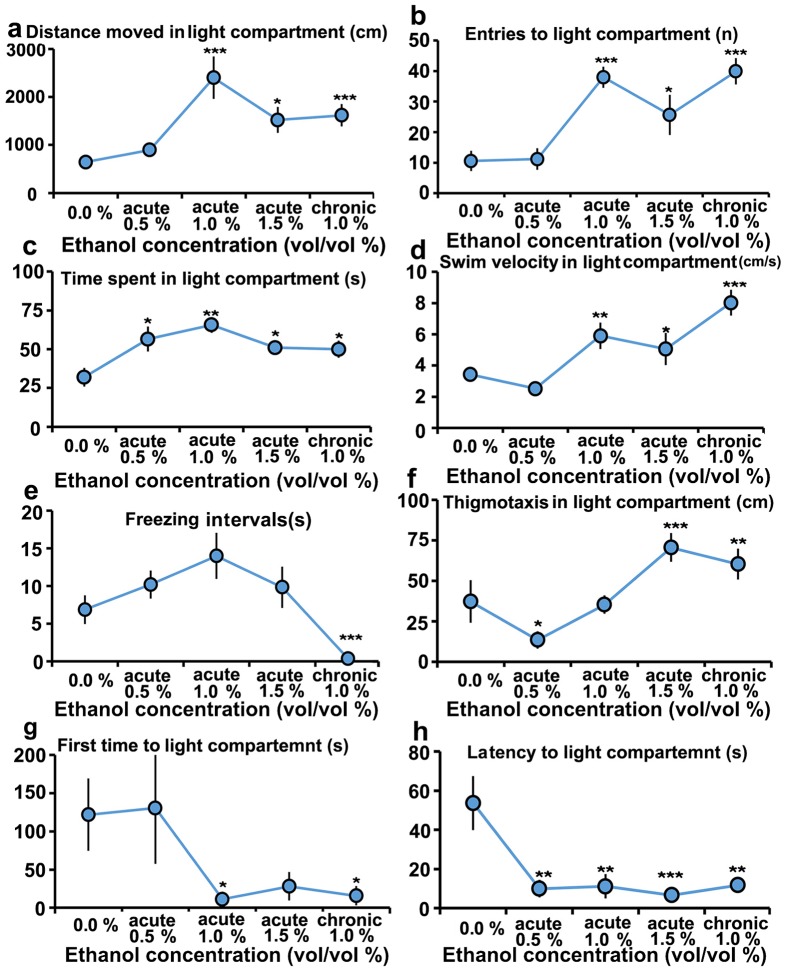
Effects of acute (0.5%, 1.0% and 1.5%) and chronic (1.0%) alcohol exposure on zebrafish behavior in light and dark preference tests.
(a) Distance moved (cm) in the light compartment. (b) Entries (number of times) to the light compartment. (c) Time spent (s) in the light compartment. (d) Swim velocity (cm/s) in the light compartment. (e) Freezing intervals (s) in the light compartment. (f) Thigmotaxis (cm) in the light compartment. (g) First time (s) to the light compartment. (h) Latency (s) to the light compartment. The asterisks represent significant differences between the alcohol-treated and wild-type (0.0%) fish; an asterisk close to the balls indicates a significant difference between the treated (or untreated) and wild-type zebrafish. The data represent the means ± SEM of n = 12 zebrafish. *p < 0.05, **p <0.01, ***p <0.001.